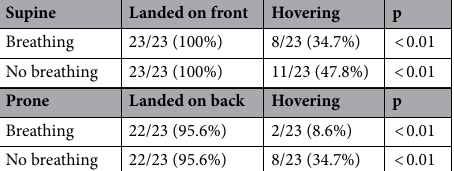
Table 2. Classification of the correct judgment of breathing. Chi-square analyses were performed.